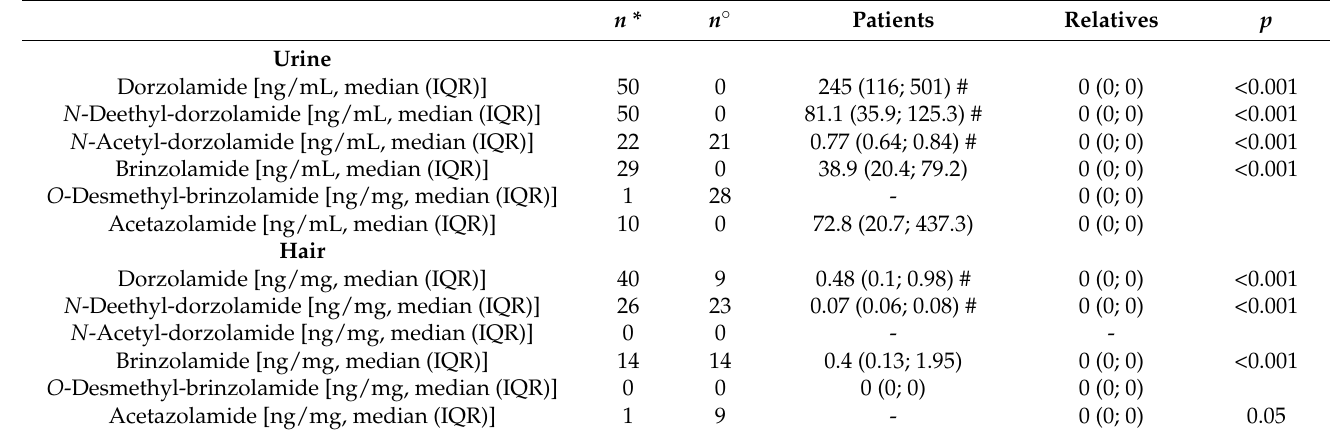
Table 2. Comparisons of substances and metabolites concentrations between patients and their relatives. n * n ◦ Patients Relatives